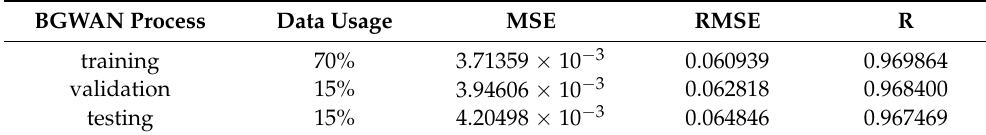
Table 1. ANN operation. Figure 4. Regression Plot.